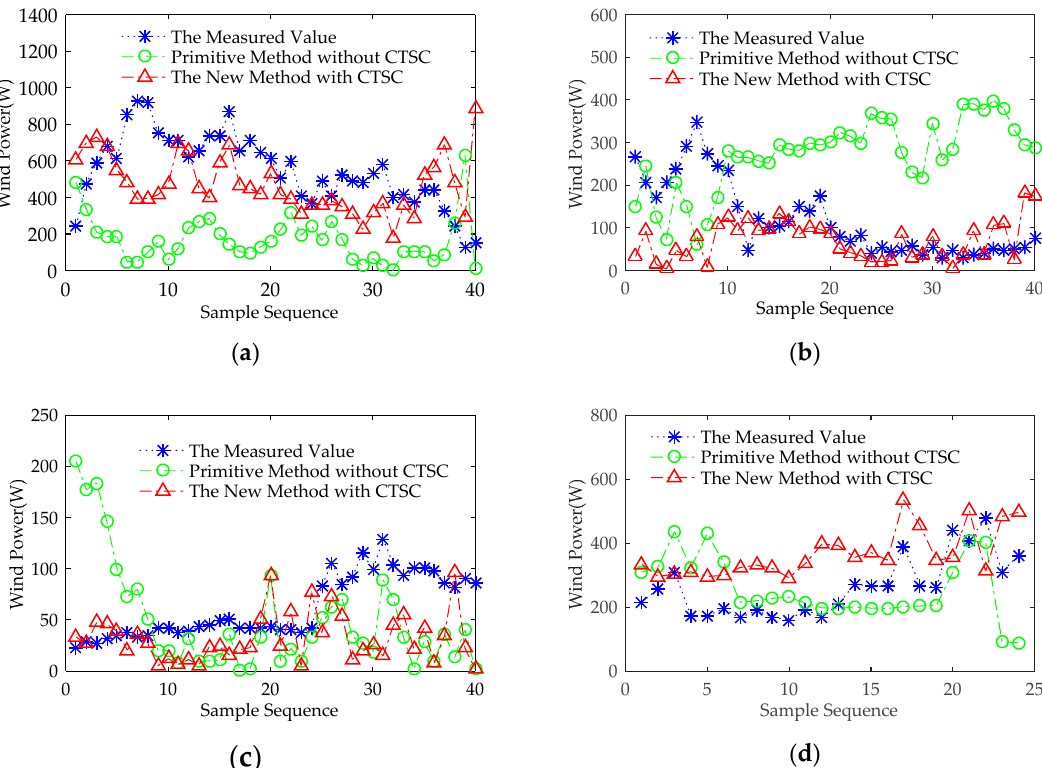
Figure 3. All-day deterministic power forecasting results on February 7, 2019. ( a ) [00:00–6:40] Prediction Chart. ( b ) [6.40:00–13:20] Prediction Chart. ( c ) [13:20–20:00] Prediction Chart. ( d ) [20:00–24:00] Prediction Chart. Table 1. Experimental results of two models.